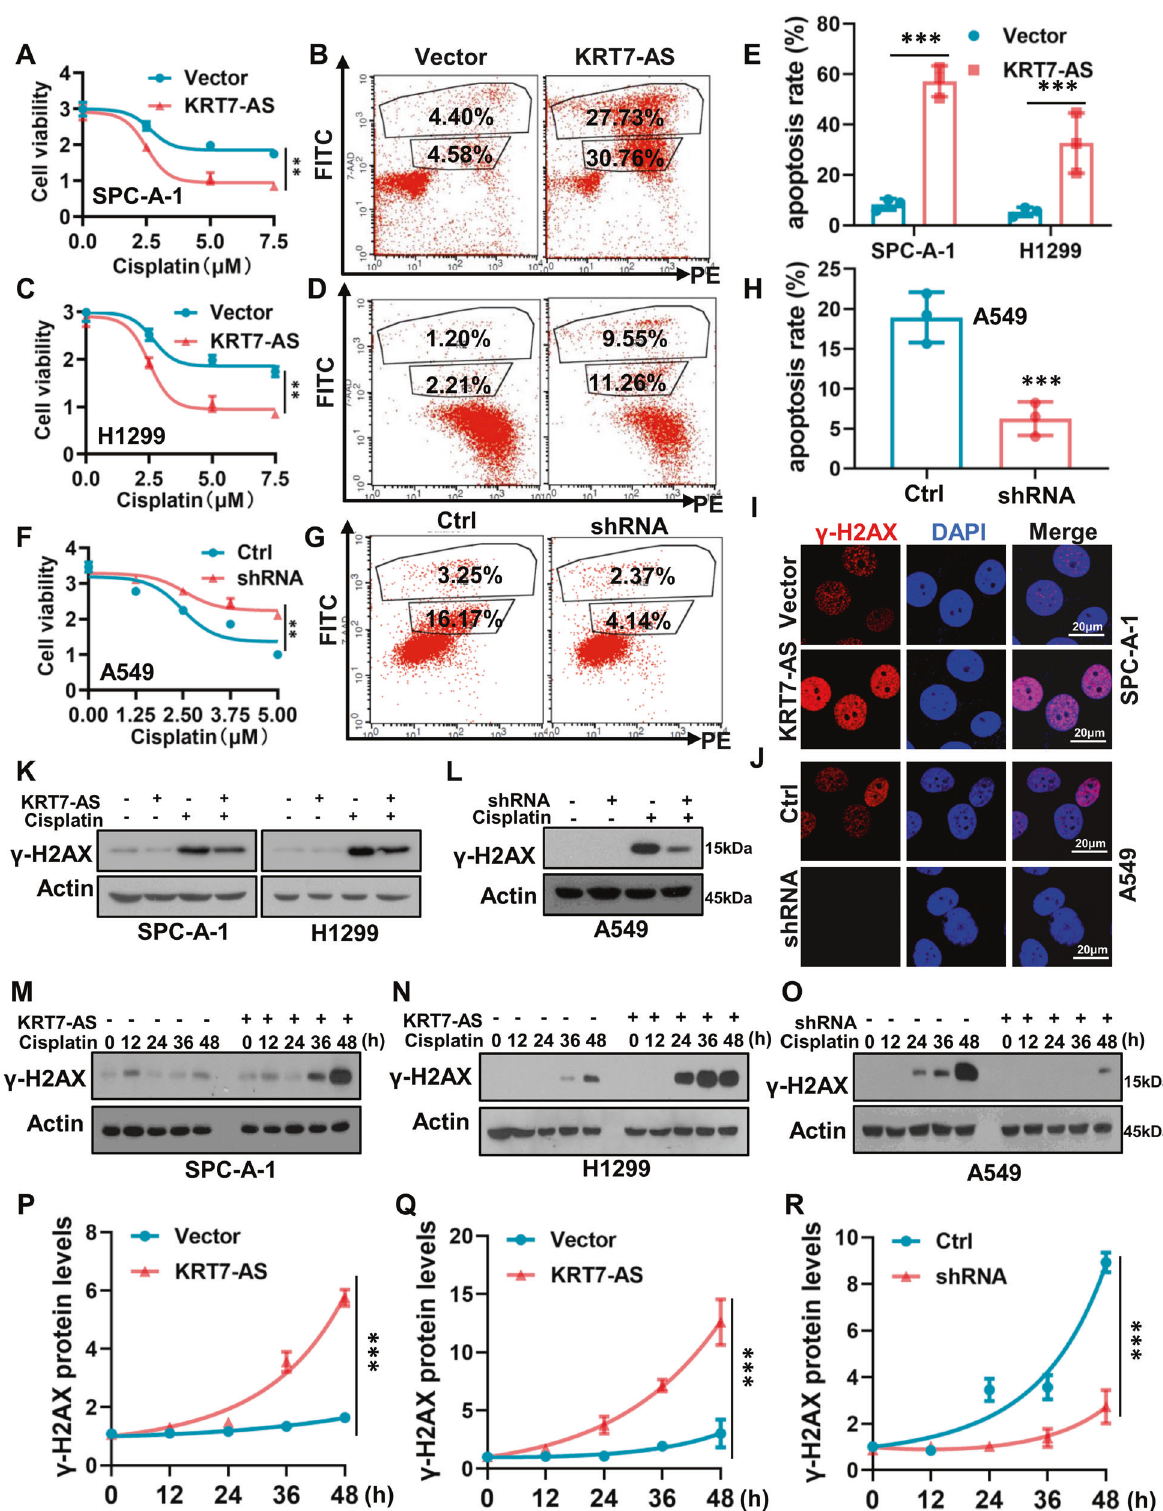
Fig. 4 Upregulation of KRT7-AS enhances cisplatin-induced DNA damage and increases lung cancer cell sensibility to the drug. Cell Titer- Glo luminescent (CTG) assay showed that KRT7-AS overexpression enhanced the sensibility of SPC-A-1 ( A ) and H1299 ( C ) lung cancer cells to the anti-cancer drug cisplatin. Flow cytometry analysis showed that KRT7-AS overexpression signi fi cantly enhanced cisplatin-induced apoptosis of SPC-A-1 ( B , E ) and H1299 ( D , E ) lung cancer cells. CTG and fl ow cytometry analysis showed that in KRT7-AS- silenced A549 lung cancer cells, reduction of KRT7-AS levels diminished cisplatin-induced apoptosis ( F , G , H ). The effect of KRT7-AS on the DNA damage marker γ -H2AX in KRT7-AS-overexpressed SPC-A-1 and KRT7-AS-silenced A549 cells in the presence of cisplatin was accessed by IF staining ( I , J ) and Western blotting ( K , L ). Time course study showed that KRT7-AS-induced elevation of γ -H2AX levels in SPC-A-1 ( M , P ), H1299 ( N , Q ), and A549 ( O , R ) lung cancer cells was in a time-dependent manner (M-R). Data are shown as mean ± SD of three independent replicates. ** P < 0.01, *** P < 0.001. Cell Death and Disease (2023)